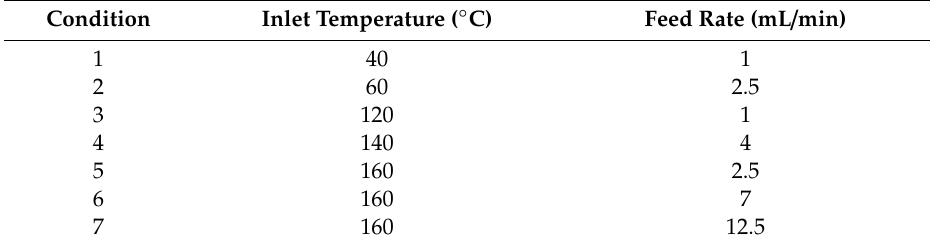
Table 1. Conditions used to determine the optimal SD parameters. The atomizing airflow, aspirator airflow, and final concentration in the feed solution were all kept